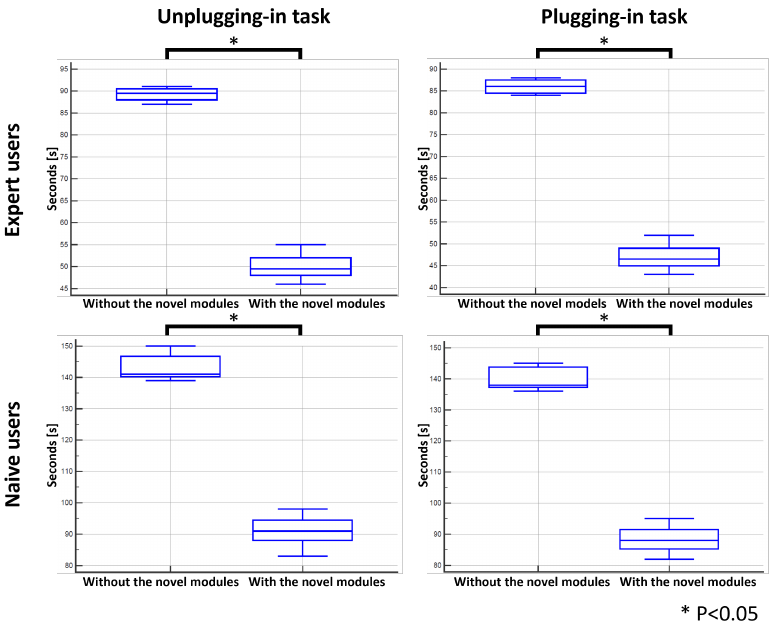
Figure 7. Task execution time (in seconds) for expert and naive operators. Statistical significance when the novel modules were used is indicated with * p < 0.05 (Mann–Whitney test).